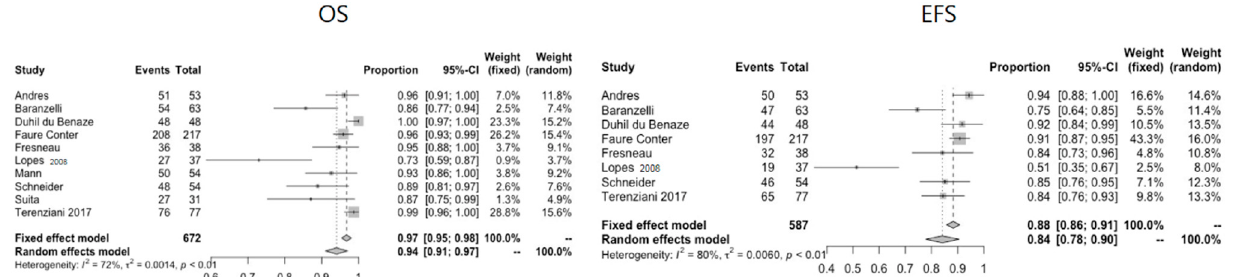
Figure 3. Pooled OS and EFS data for ovarian GCTs.